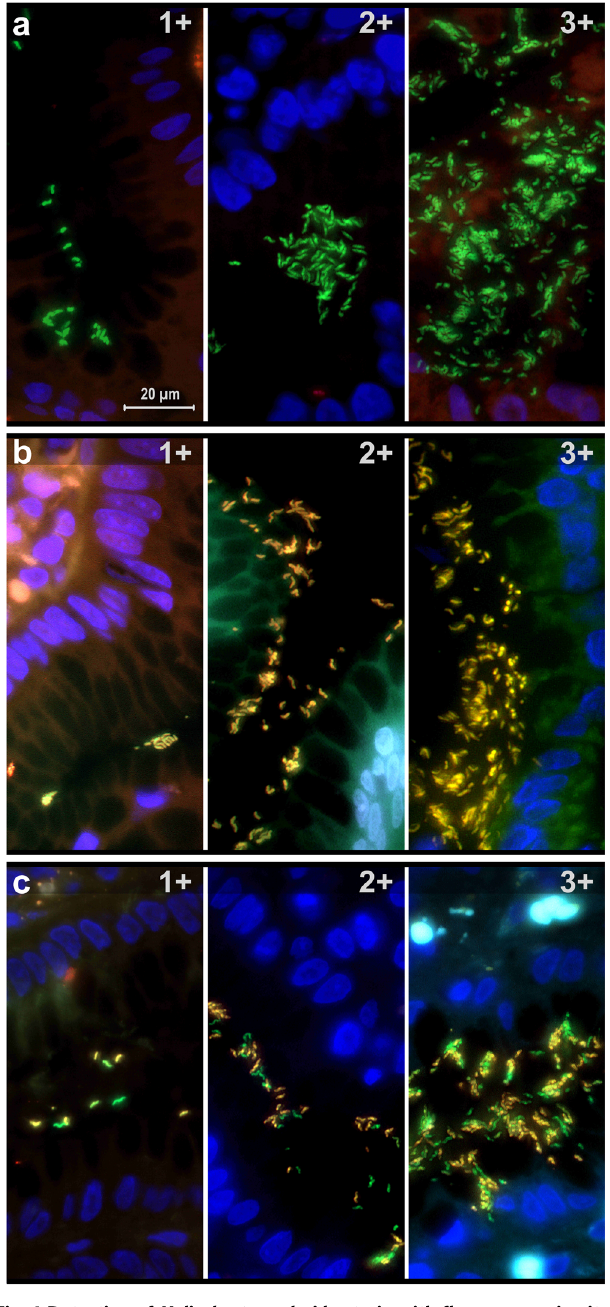
Fig. 1 Detection of Helicobacter pylori bacteria with fl uorescence in situ hybridization (FISH) in gastric tissue samples. a Clarithromycin- susceptible bacteria appear in green. b In clarithromycin-homoresistant infection, resistant H. pylori bacteria show yellow fl uorescence. c In clarithromycin-heteroresistant H. pylori infection, a mixed population of susceptible (green) and resistant (yellow) bacteria is present. 1 + /2 + /3 + : low/moderate/high H. pylori density. Original magni fi cation: 1000×. For further details, see “ Clarithromycin susceptibility FISH test ” in the